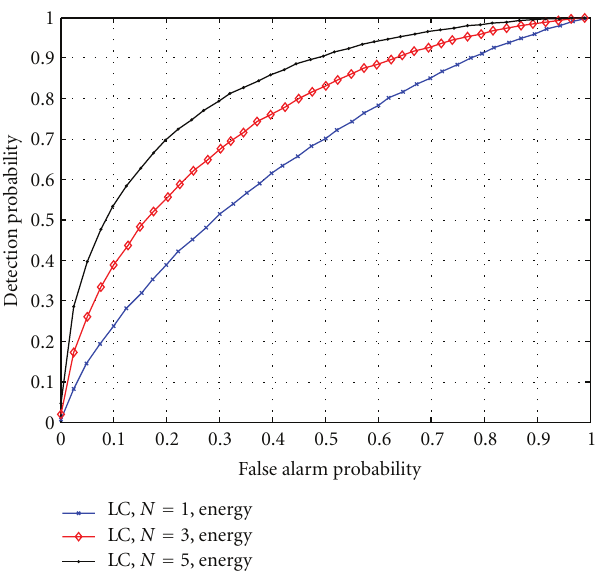
Figure 6: ROC curves of energy-based linear classifier scheme: SNR avg = − 14dB and M = 200bits.